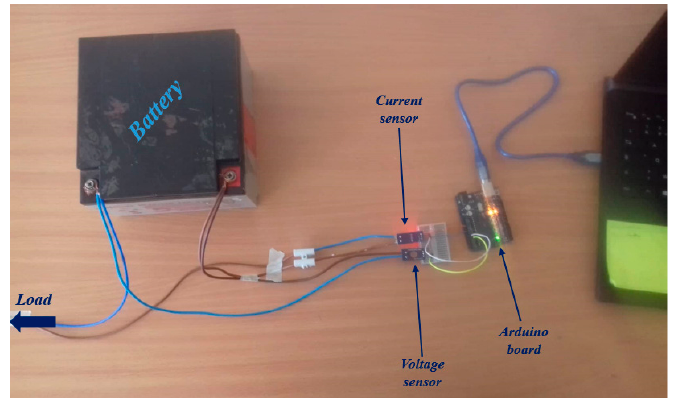
Figure 4. Battery characterization test-bed.